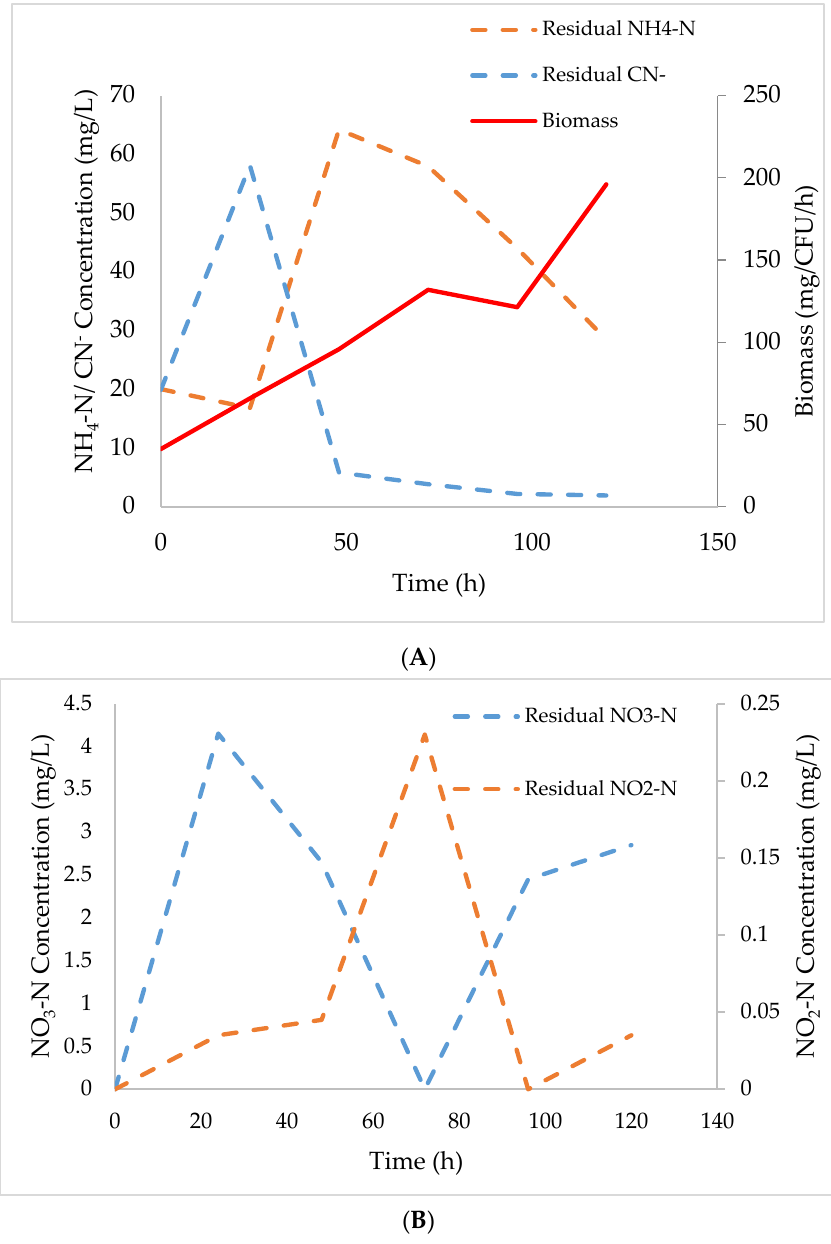
Figure 1. Biodegradation kinetics of NH 4 -N and CN − by Acinetobacter courvalinii . ( A ): Growth of Acinetobacter courvalinii, sequential degradation of CN − and NH 4 -N. ( B ): NO 2 -N and NO 3 -N accumulation and degradation.